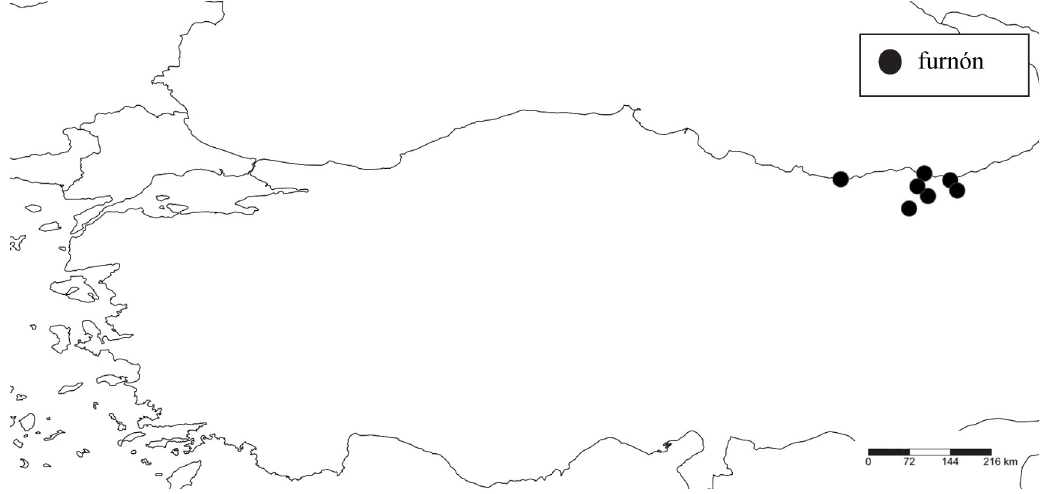
Fig 5. The distribution of the term φουρνόν ( furnón ) in Pontus in the early 20 th century, based on the origin of the Pontian refugees who still use this zoonym, but also on the current speakers of Romeyka in Turkey.